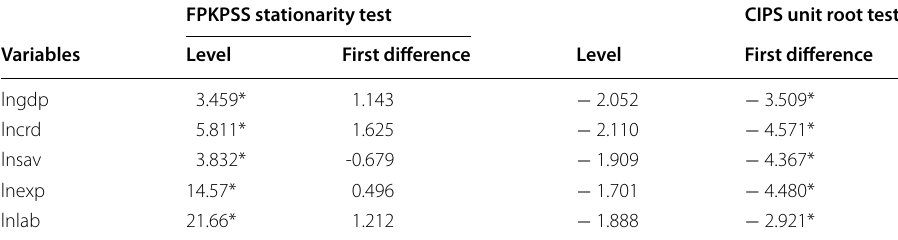
*Indicates the rejection of the null hypothesis at a 1% significance level. The null hypothesis of the FPKPSS test is stationarity